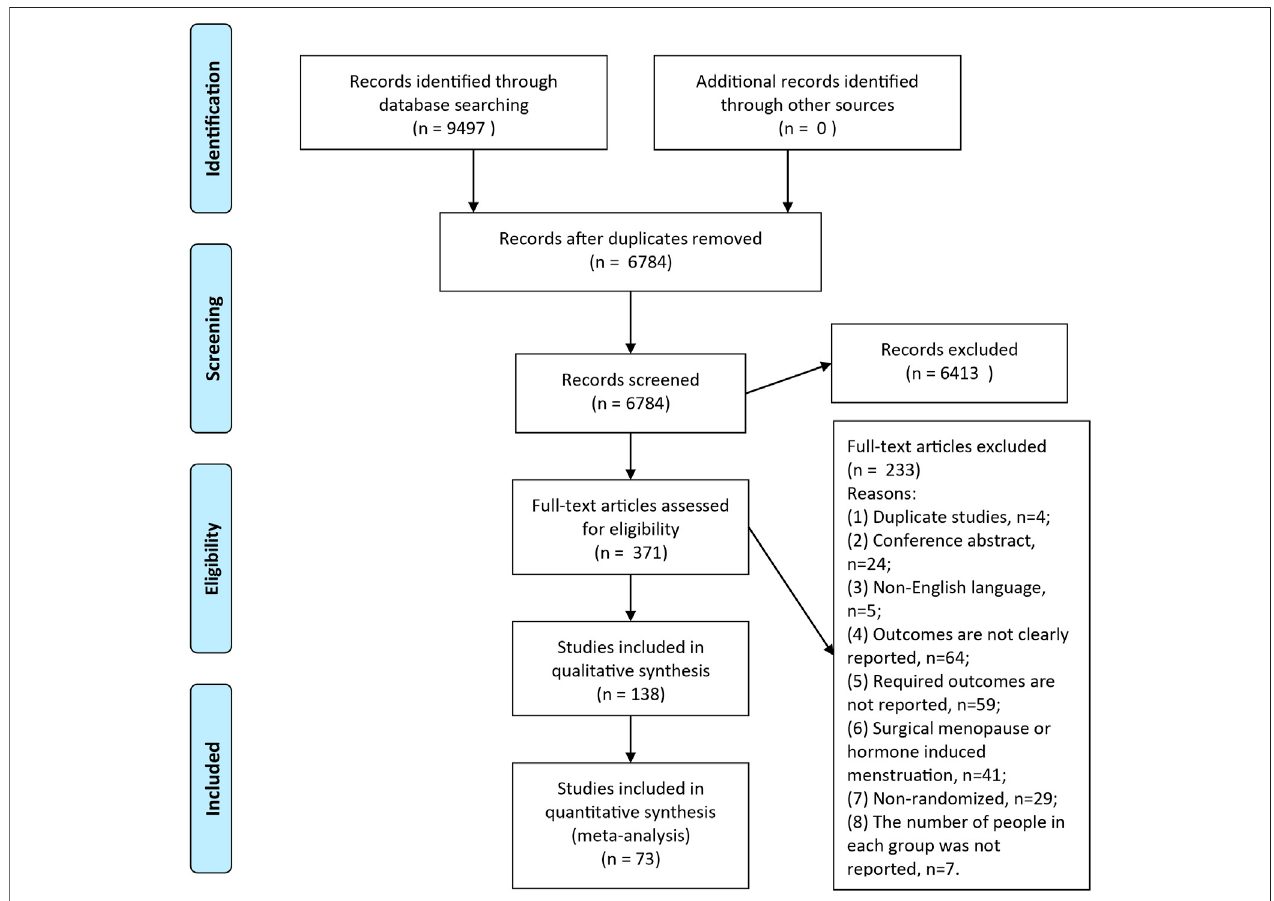
FIGURE 1 | Flow Diagram. A total of 6,784 articles were retrieved, and 73 articles were included in the current meta-analysis.